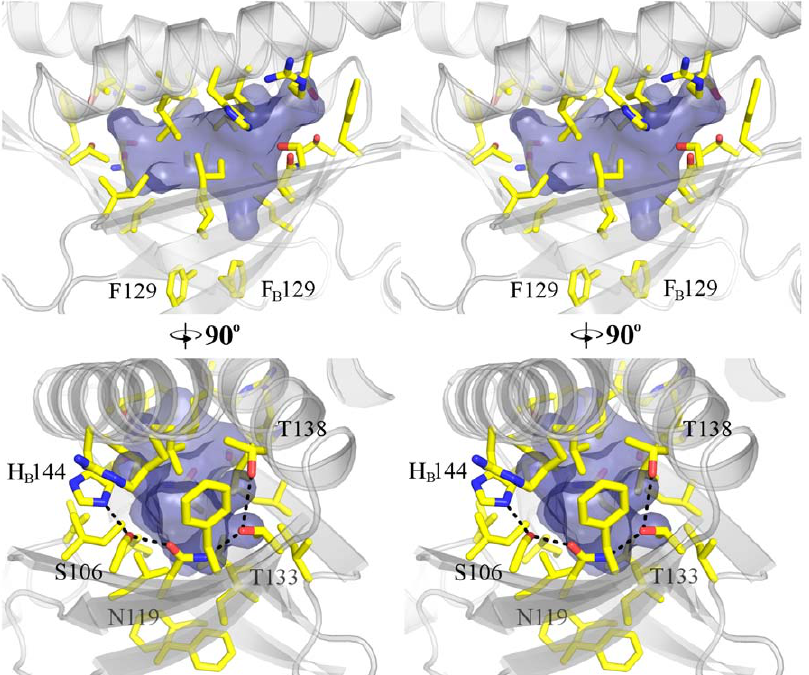
Figure 5. Stereo image of the hydrophobic pocket in Cpn0803. Dimerization of Cpn0803 results in the formation of a cone-shaped hydrophobic pocket between the two 3-stranded b -sheets, closed off at the ‘top’ by a -6 from both chains A and B, and stoppered at the ‘bottom’ by F129. The amino acid residues lining the interior of the pocket are represented in stick form.